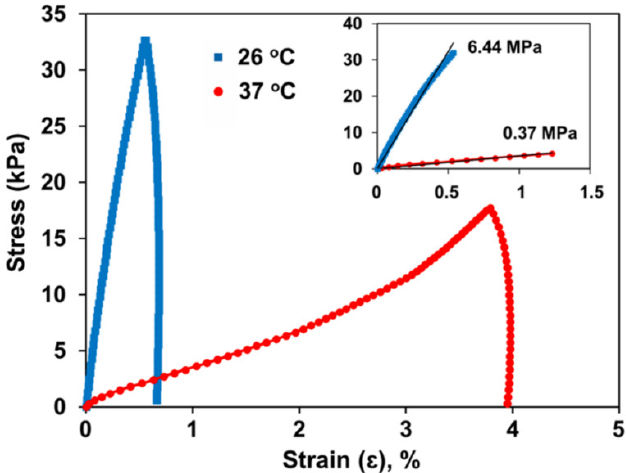
Figure 5. Stress–strain curve for paraffin wax at various temperatures. The Young’s modulus of the material decreases significantly with increasing temperature. This decrease in paraffin wax stiffness with increased temperature is the mechanism behind the self-folding ability of soft metallic microgrippers. Reproduced with permission from Ref. [16]. Copyright 2020.